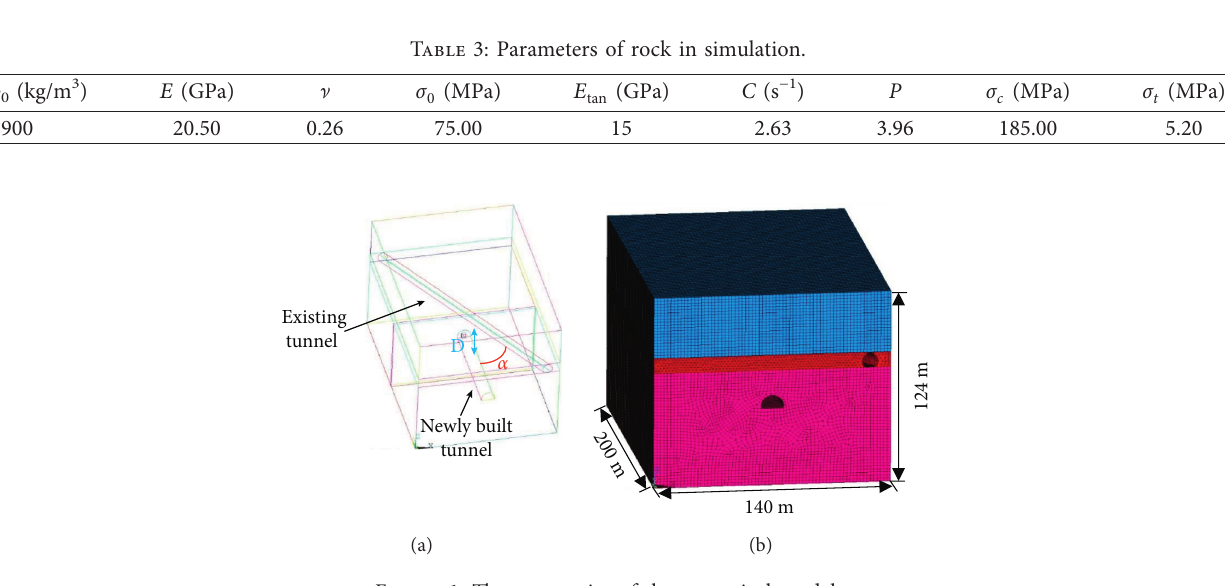
Figure 1: The geometries of the numerical model. Table 4: The arrangement of testing conditions.